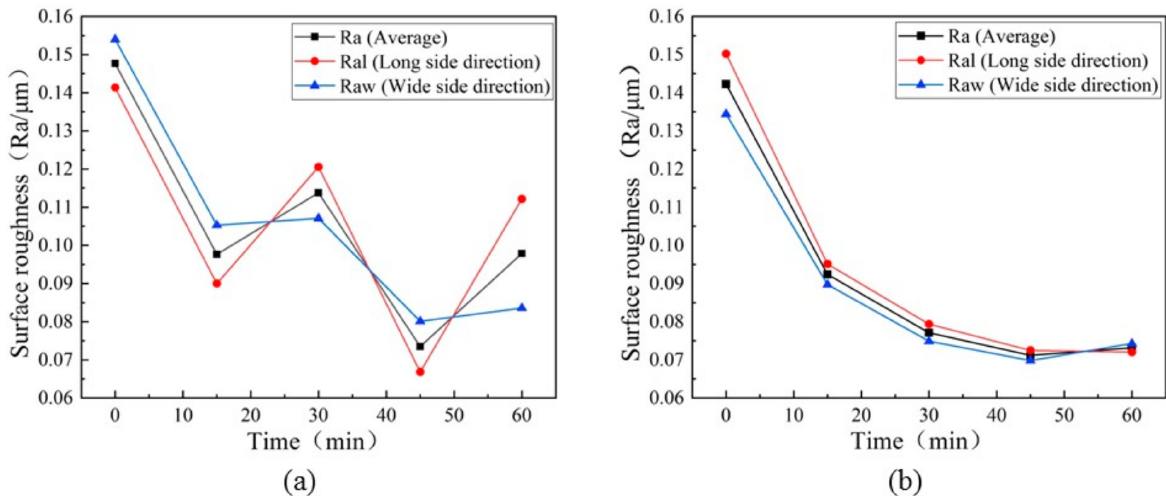
Figure 10. Comparison of surface roughness in different test directions between ( a ) traditional contact grinding and ( b ) non-contact ultrasonic